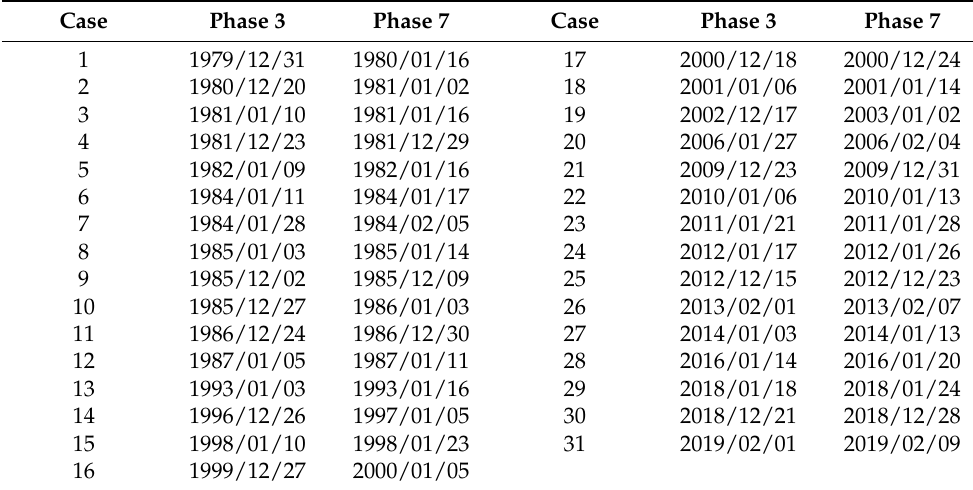
Table 1. The specific dates of peak phase (phase 3) and valley phase (phase 7) of 31 LECEs in the NE-N region. Case Phase 3 Phase 7 Case Phase